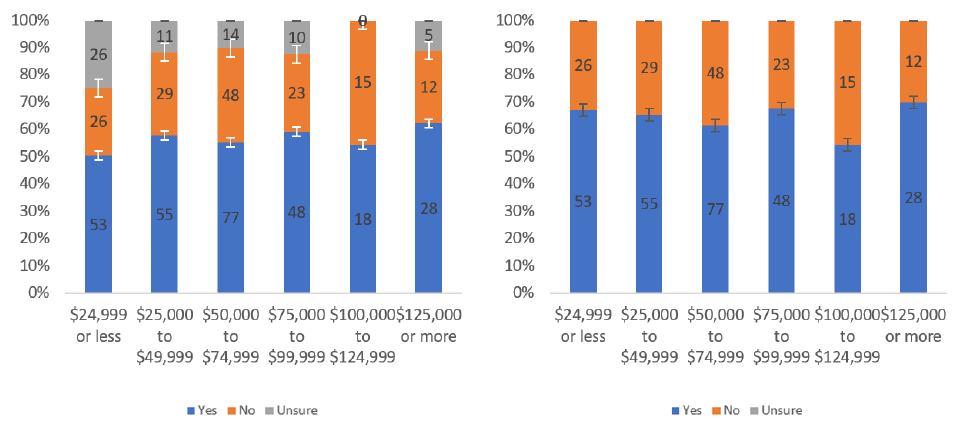
Figure 45. Responses regarding respondents’ willingness to review by income level including ( left ) and excluding ( right ) unsure responses.